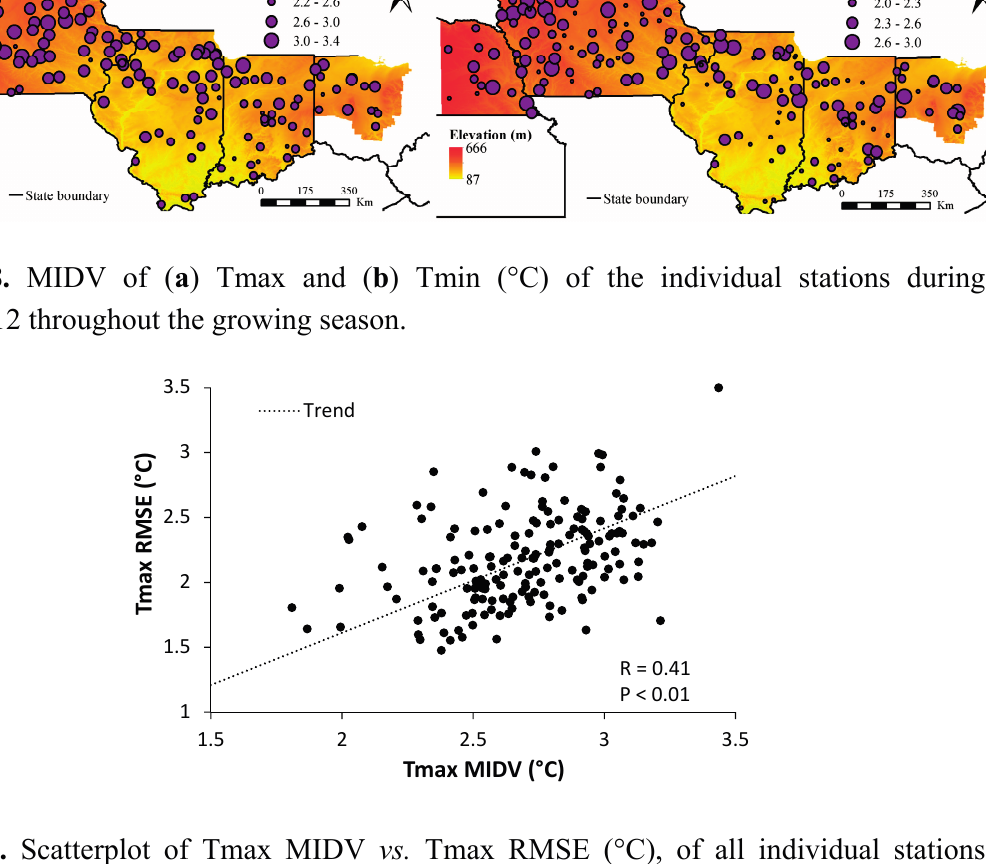
Figure 9. Scatterplot of Tmax MIDV vs. Tmax RMSE (°C), of all individual stations included in this study during 2008 to 2012.